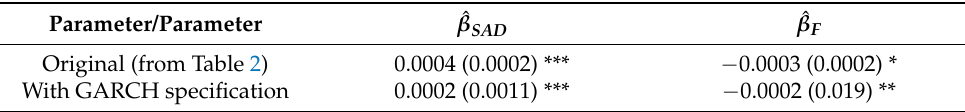
Table 5. Robustness check of results for Model 2, returns vs. excess